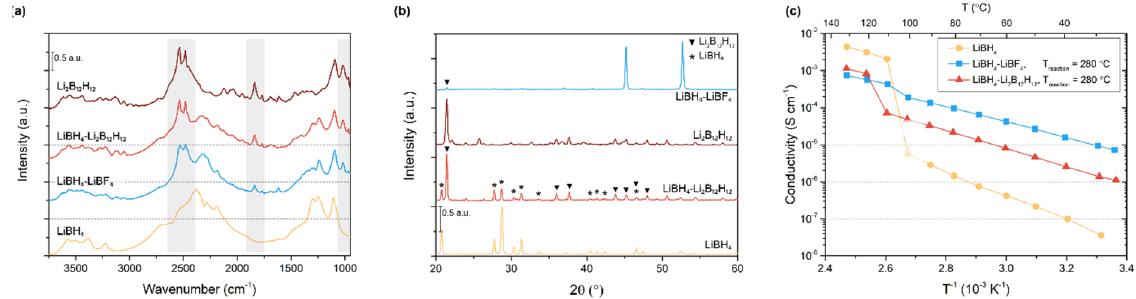
Figure 3. ( a ) DRIFTS spectra, ( b ) XRD diffraction patterns and ( c ) Arrhenius conductivity plots of LiBH 4 -LiBF 4 and LiBH 4 -Li 2 B 12 H 12 mixtures synthetized at 280 °C. In the DRIFTS and XRD graphs, LiBH 4 and Li 2 B 12 H 12 are included for comparison. In the DRIFTS, spectra peaks related to Li 2 B 12 H 12 vibrations are highlighted in grey.